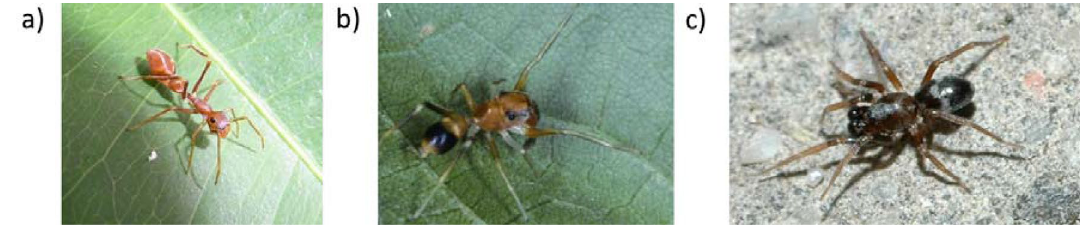
Figure 1. ( a ) Adult female of Myrmarachne assimilis ©Takeshi Yamasaki 43 with permission; ( b ) adult female of Myrmarachne bakeri ©Robert R. Jackson 44 with permission; ( c ) adult male of Phrurolithus festivus ©Rudolf Macek (www. pavou ci- cz. eu).